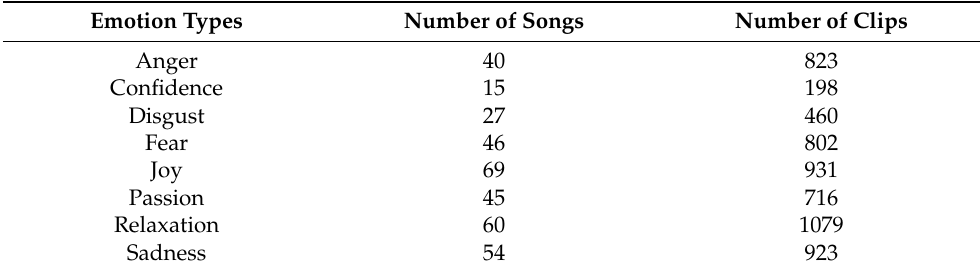
Table 3. Statistics of emotional music